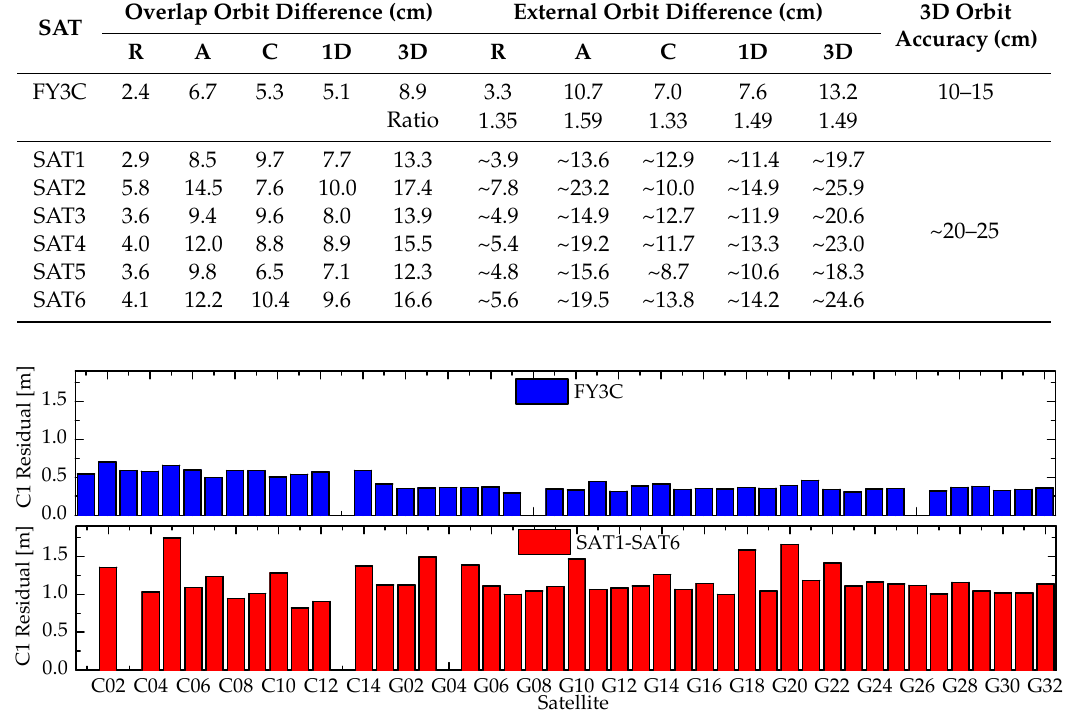
Figure 3. The RMS statistics of single-frequency pseudo-range residuals for the FY3C and YG30/SAT1 − SAT6 satellites.